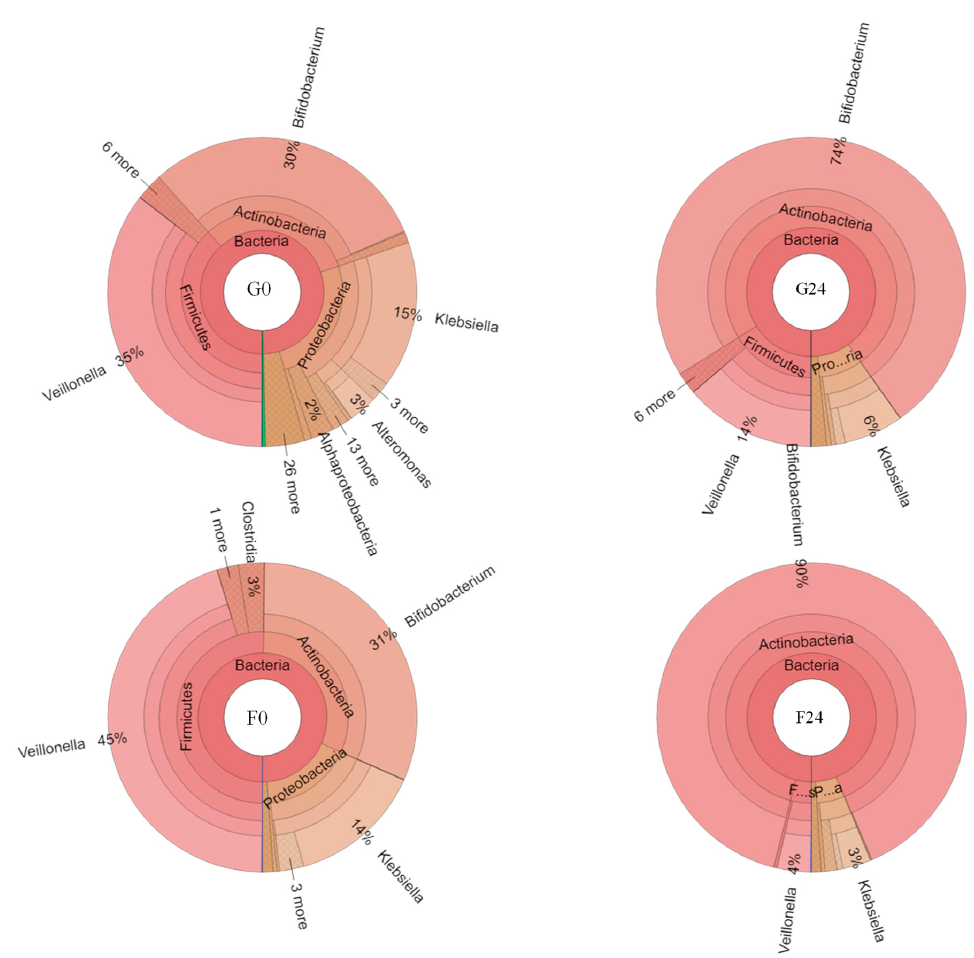
Figure 7. Krona graphs based on relative abundance of OTU up to the bacterial genus level obtained from the fermentation of glucose (G0, G24) and inulin-FOSs extract (F0, F24) at 0 and 24 h of the fermentation processes.